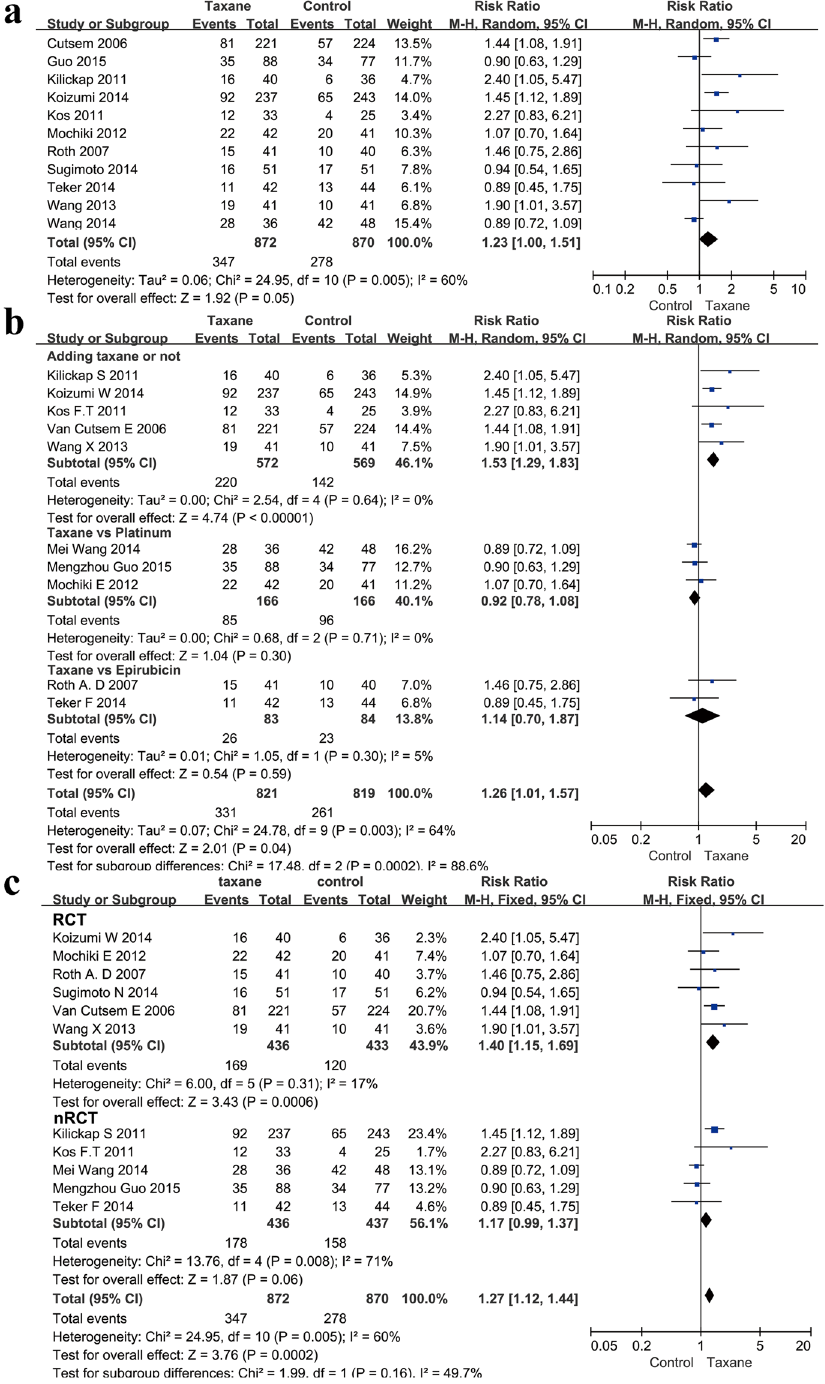
Figure 5. Meta-analysis of the overall response rate (ORR). ( a ) Forest plots of the risk ratio (RR) for the ORR comparing Taxane with control. ( b ) Subgroup analysis between the adding and replacing groups of the ORR. ( c ) Subgroup analysis between the RCT and nRCT groups of the